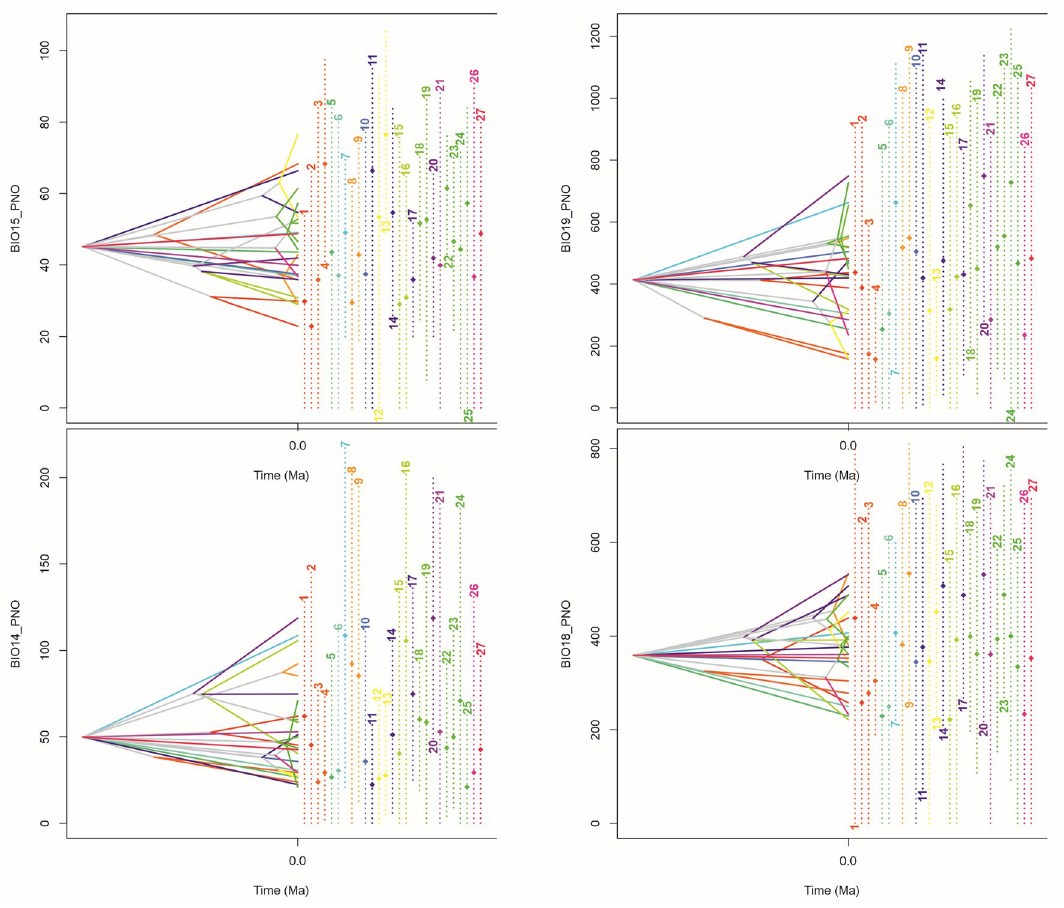
Figure 4. Ecological tolerance evolution for, BIO14 (Precipitation of Driest Month), BIO15 (Precipitation Seasonality), BIO16 (Precipitation of Wettest Quarter), BIO19 (Precipitation of Coldest Quarter); 1—